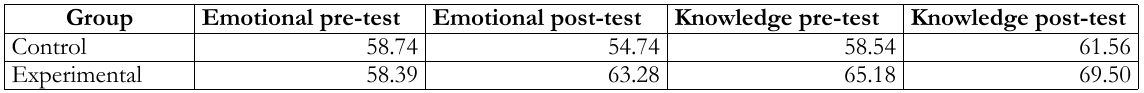
Table 1. Mean scores for emotional and knowledge acquisition yield according to pre-test and post-test